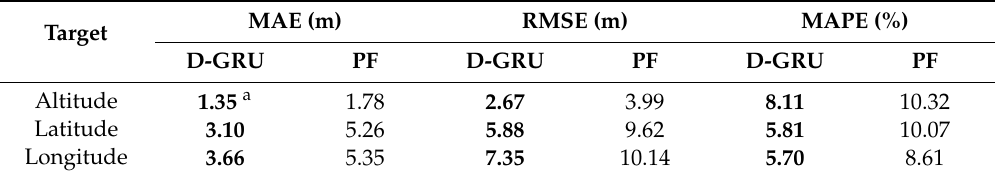
Figure 9. The real-time prediction results using D-GRU and particle filtering (PF) models. Table 5. Comparison of the prediction accuracy between the D-GRU and PF models for Mavic 2